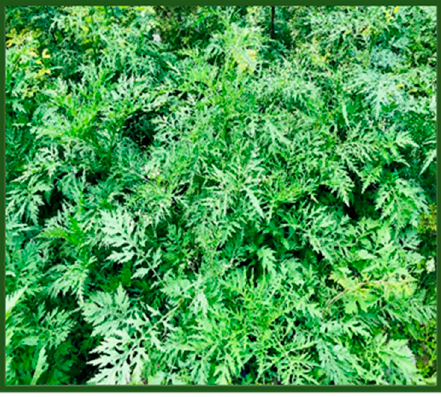
Figure 9. Parthenium hysterophorus plant.